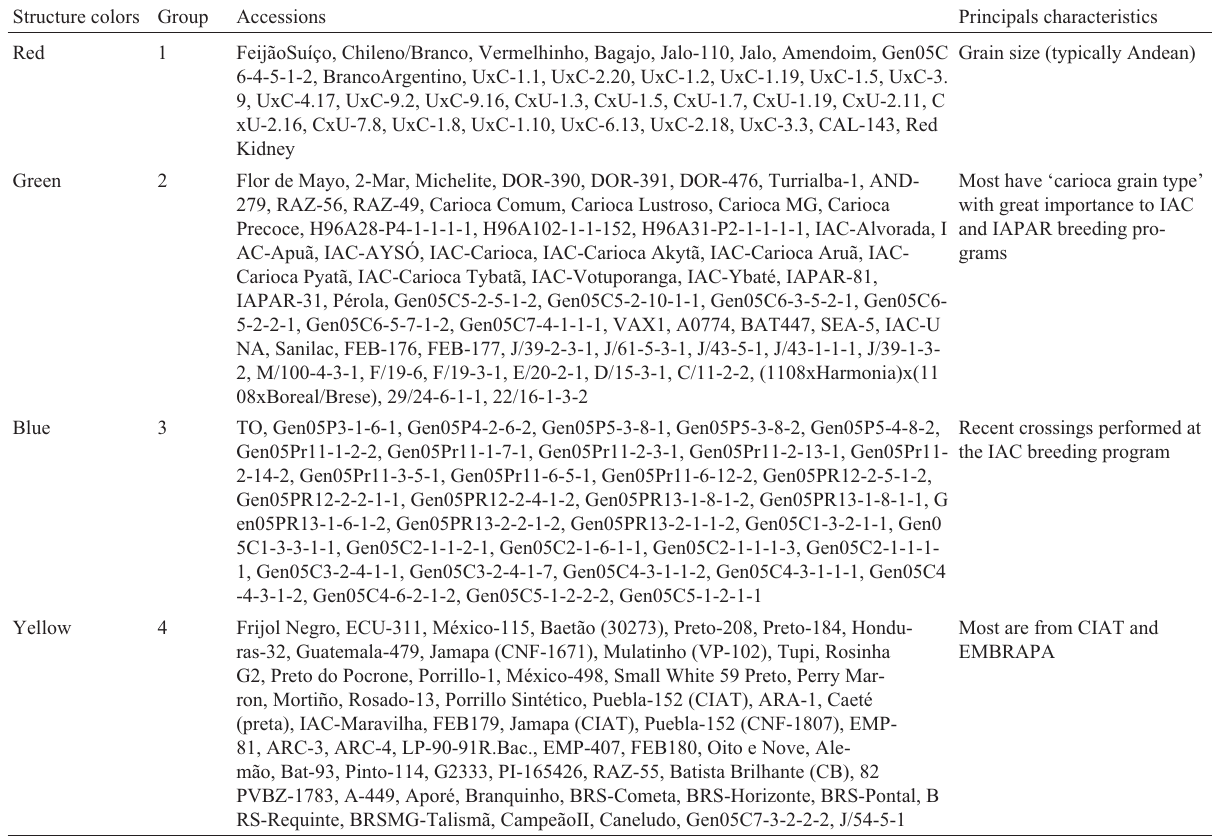
Table 2 - The 180 accessions clustered into the four groups generated by the Structure analysis and their respective traits. Structure colors